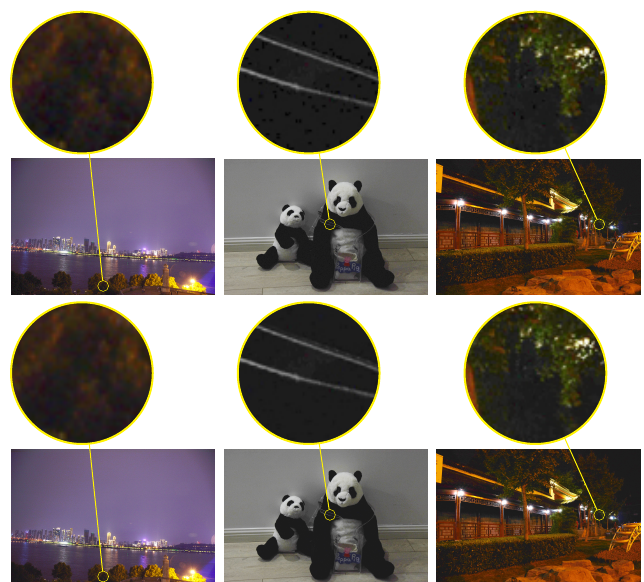
Figure 9. Results on using weighted guided image filter (WGIF)-based noise reduction when the value of a pixel is below 5, and the results of directly amplifying pixels whose value is below 5 by using constant. The first row shows no denoised images, and the second row shown denoised images. Compare the amplified red blocks in the images. The method can effectively reduce noise and preserve details.